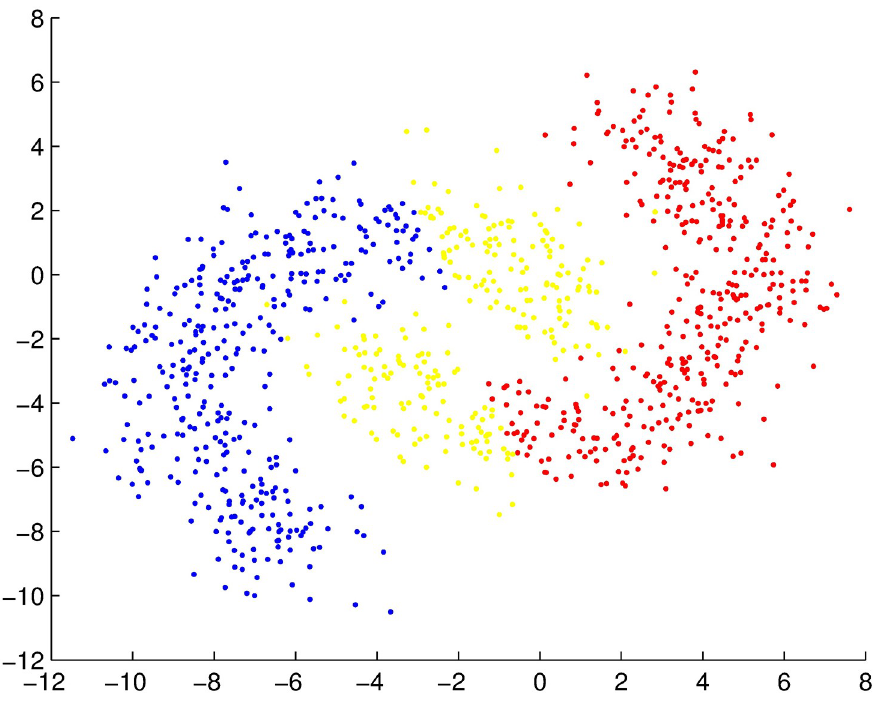
Fig 8. The 2 clusters with k-means algorithm on banana